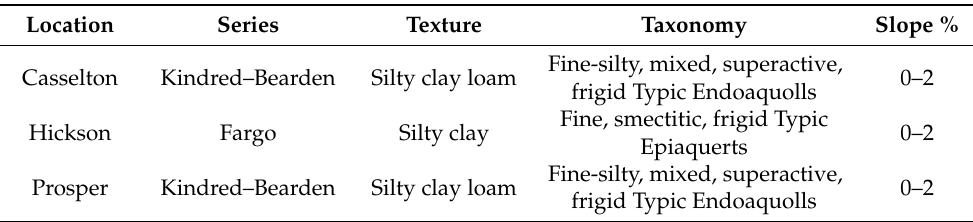
Table 1. Soil series description of experimental locations at Casselton, Hickson, and Prosper, ND, USA, in 2018 and 2019 [39]. Location Series Texture Taxonomy Slope %